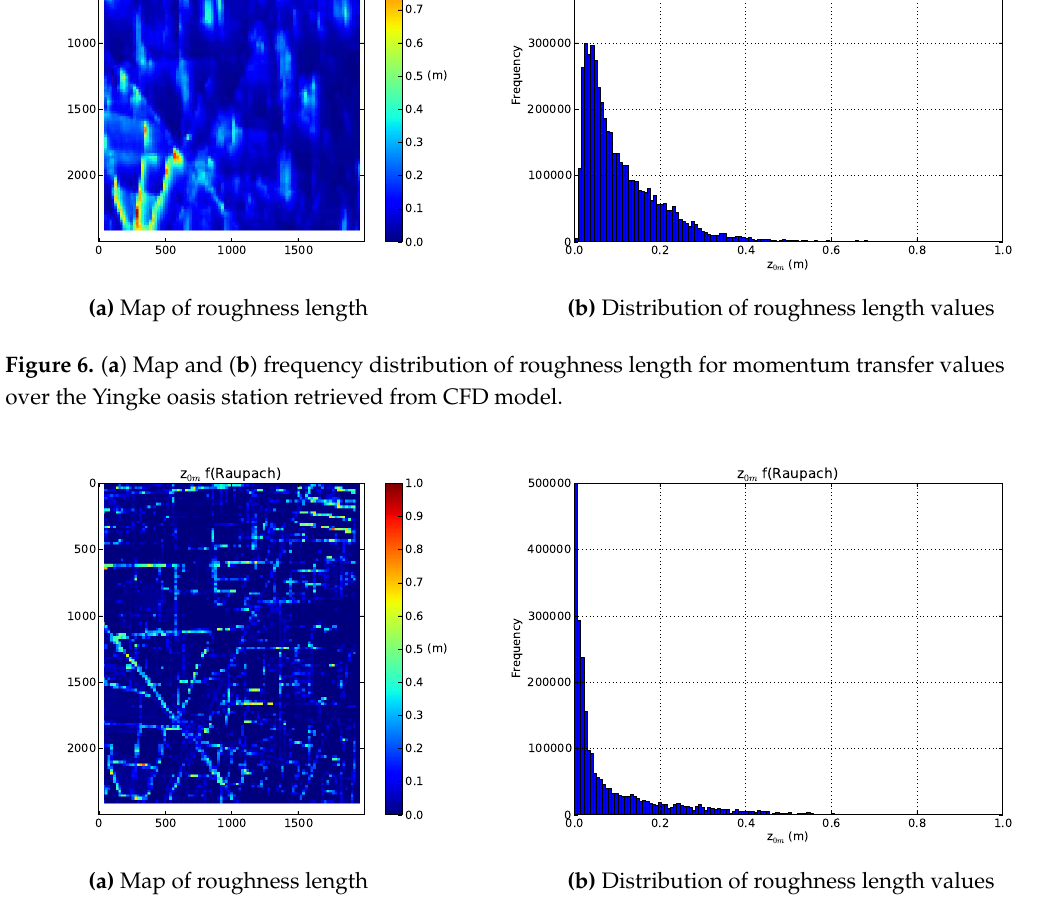
Figure 7. ( a ) Map and ( b ) frequency distribution of roughness length for momentum transfer values over the Yingke oasis station retrieved from Raupach’s